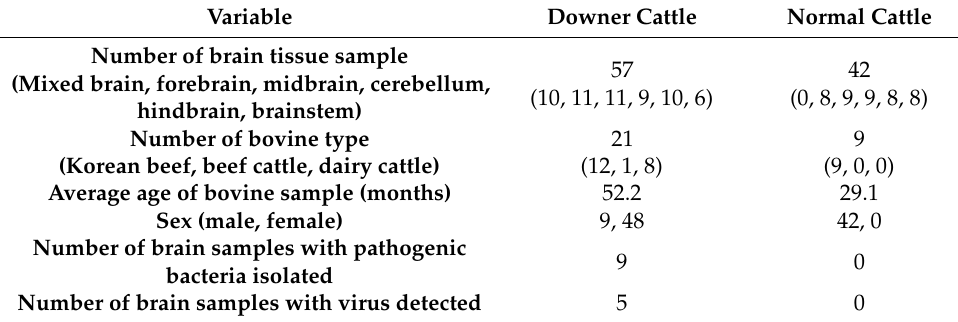
Table 1. The characteristics of downer and normal cattle. Variable Downer Cattle Normal Cattle Number of brain tissue